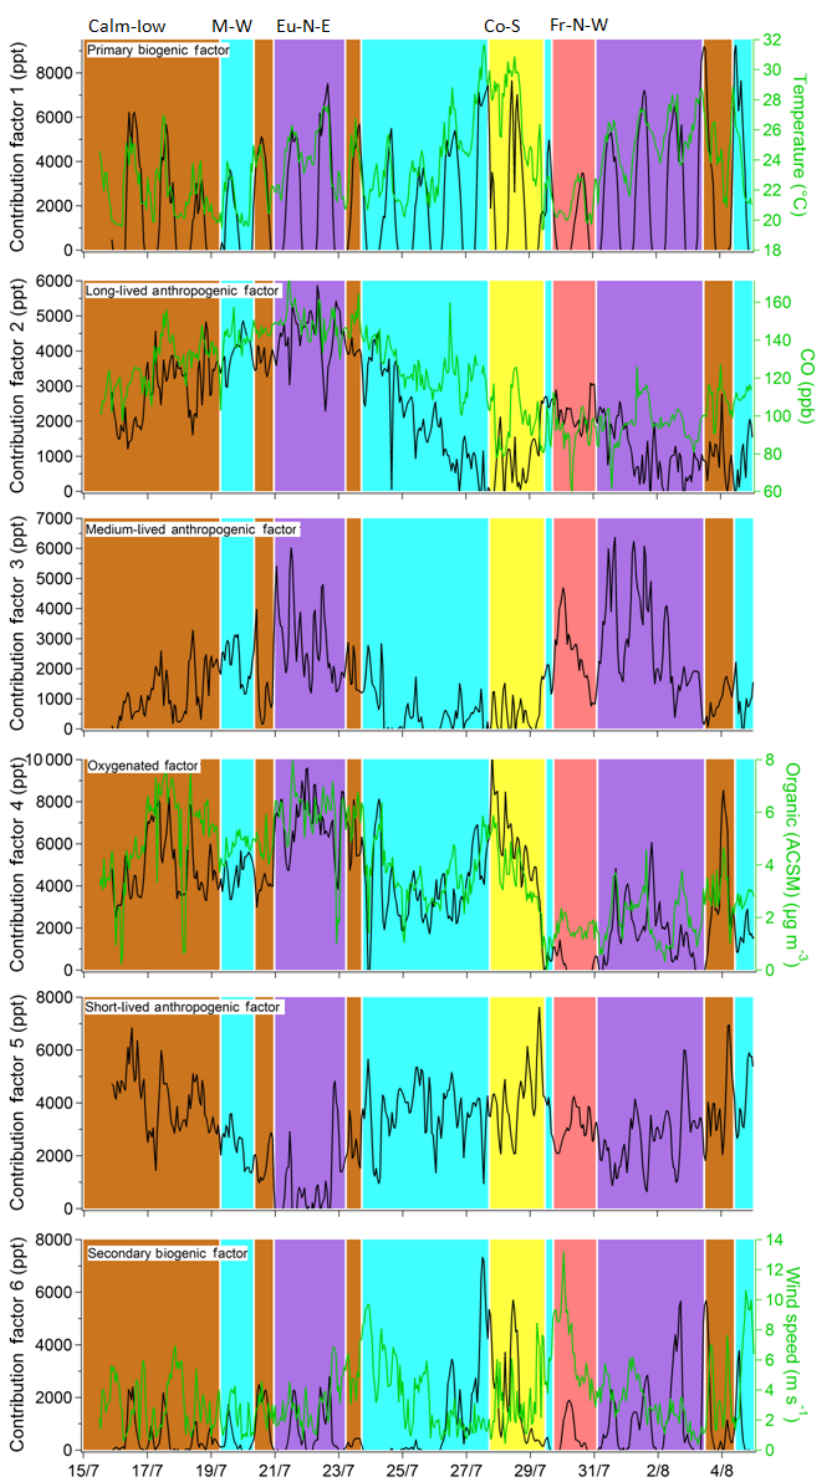
Figure 6. Time series for the contribution of the six gas-phase PMF factors together with temperature, CO, the measured organic fraction of aerosols and wind speed. The colored areas correspond to back-trajectory clusters: light blue, purple, yellow, pink and orange-brown for the marine west (M-W), Europe northeast (Eu-N-E), Corsica south (Co-S), France northwest (Fr-N-W) and calm low wind (calm-low) clusters,